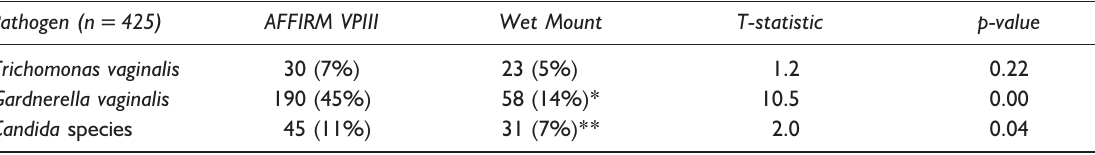
Table 1 Number of specimens positive for each organism for each test Pathogen (n =425)